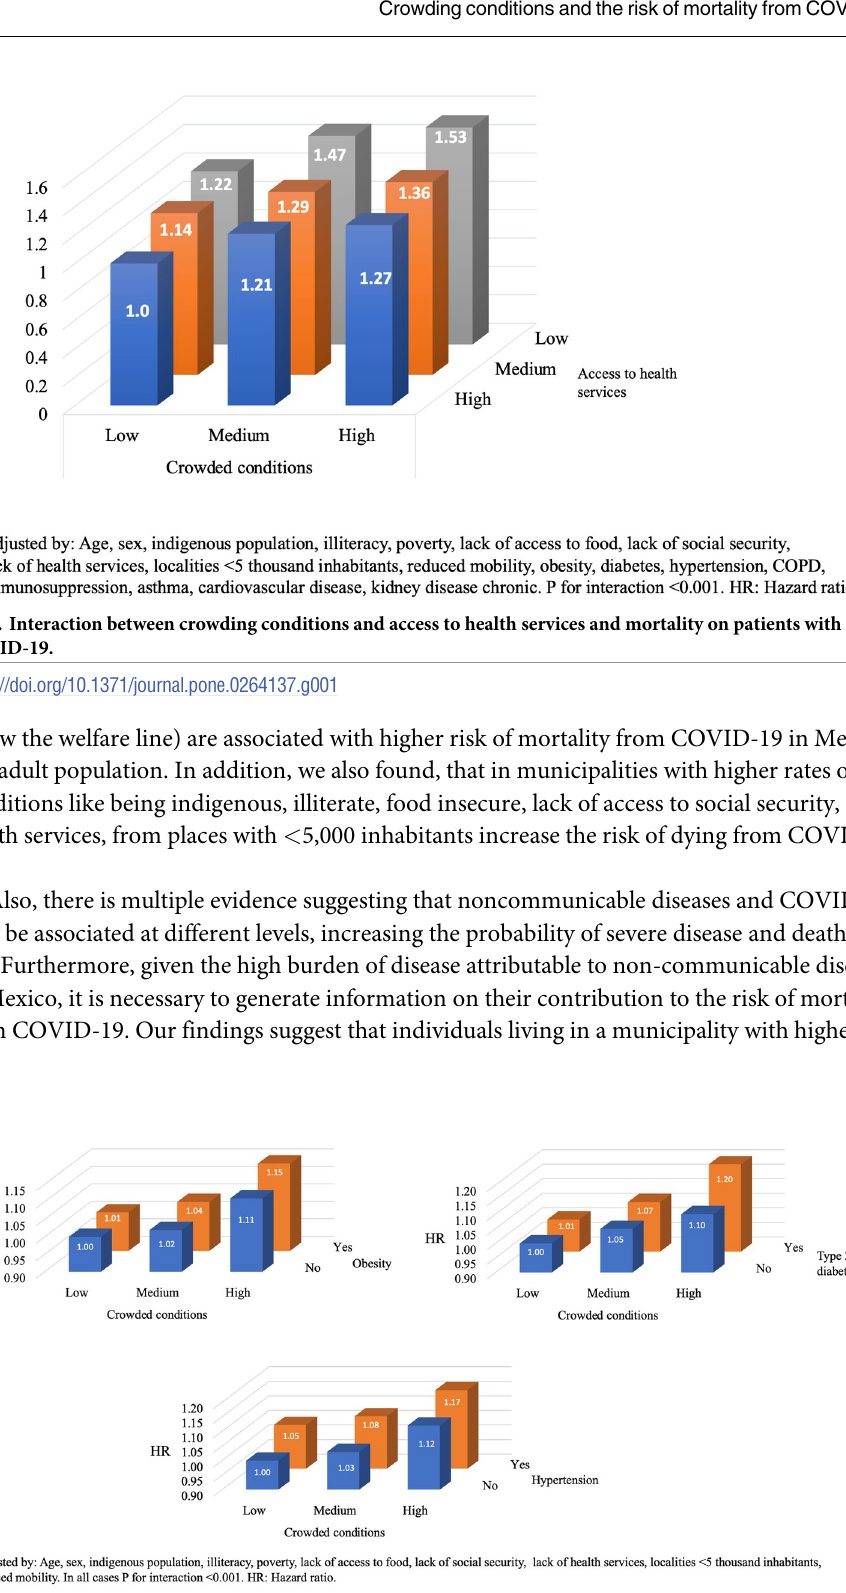
Fig 2. Interaction between crowding conditions and a) Obesity, b) Type 2 diabetes and c) Hypertension and mortality on patients with